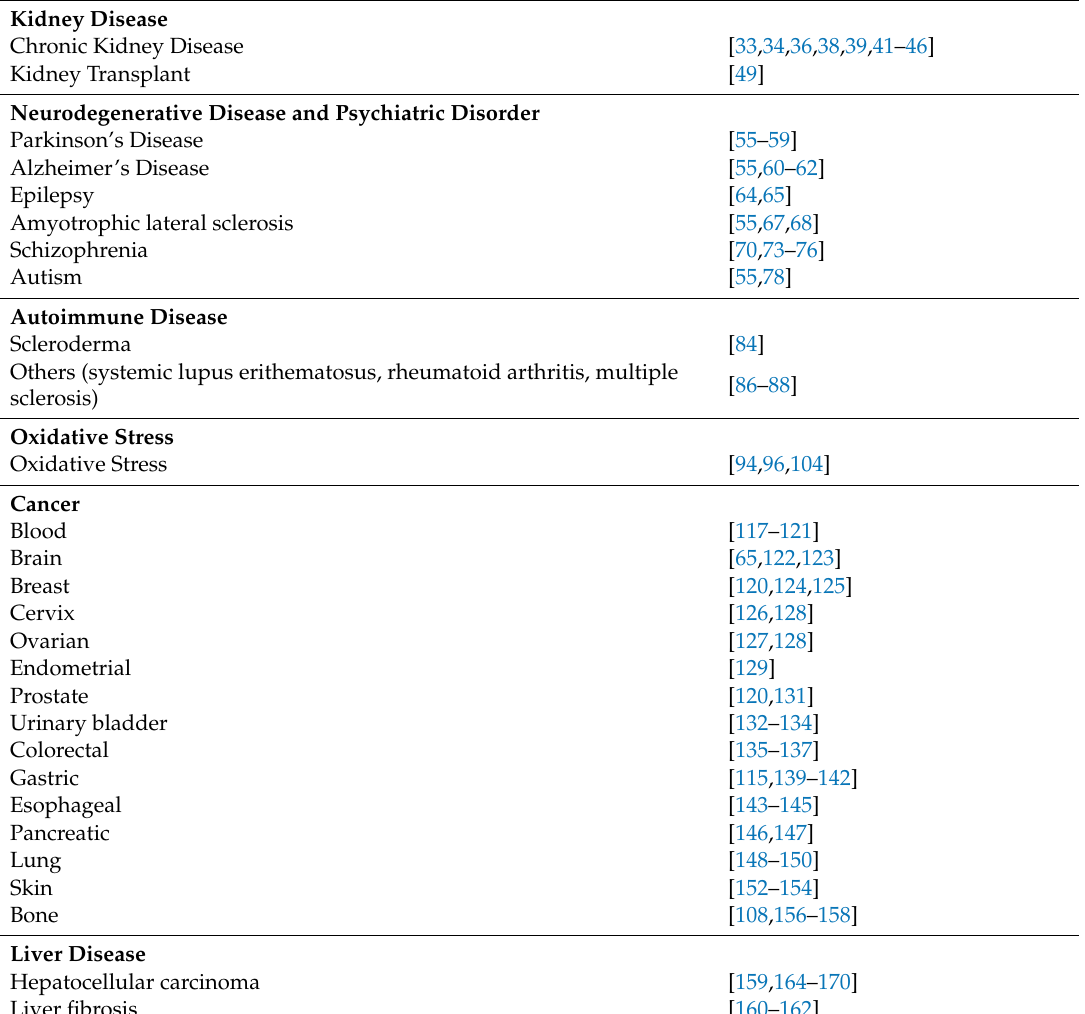
Table 4. GSTP1 in